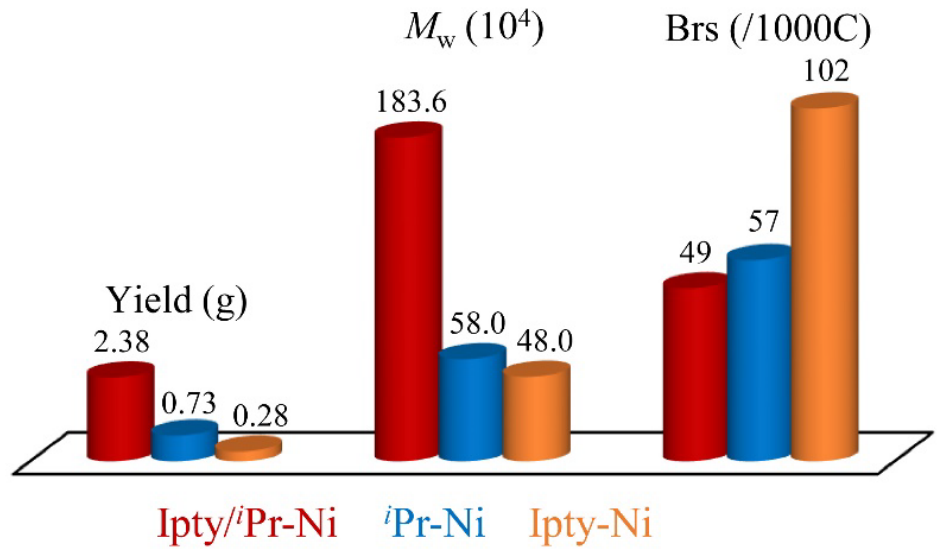
Figure 4. Comparisons of the yield, molecular weight, and branching density of polyethylenes generated by Ipty/ i Pr-Ni , i Pr-Ni and Ipty-Ni with the activation of MMAO at 30 °C.